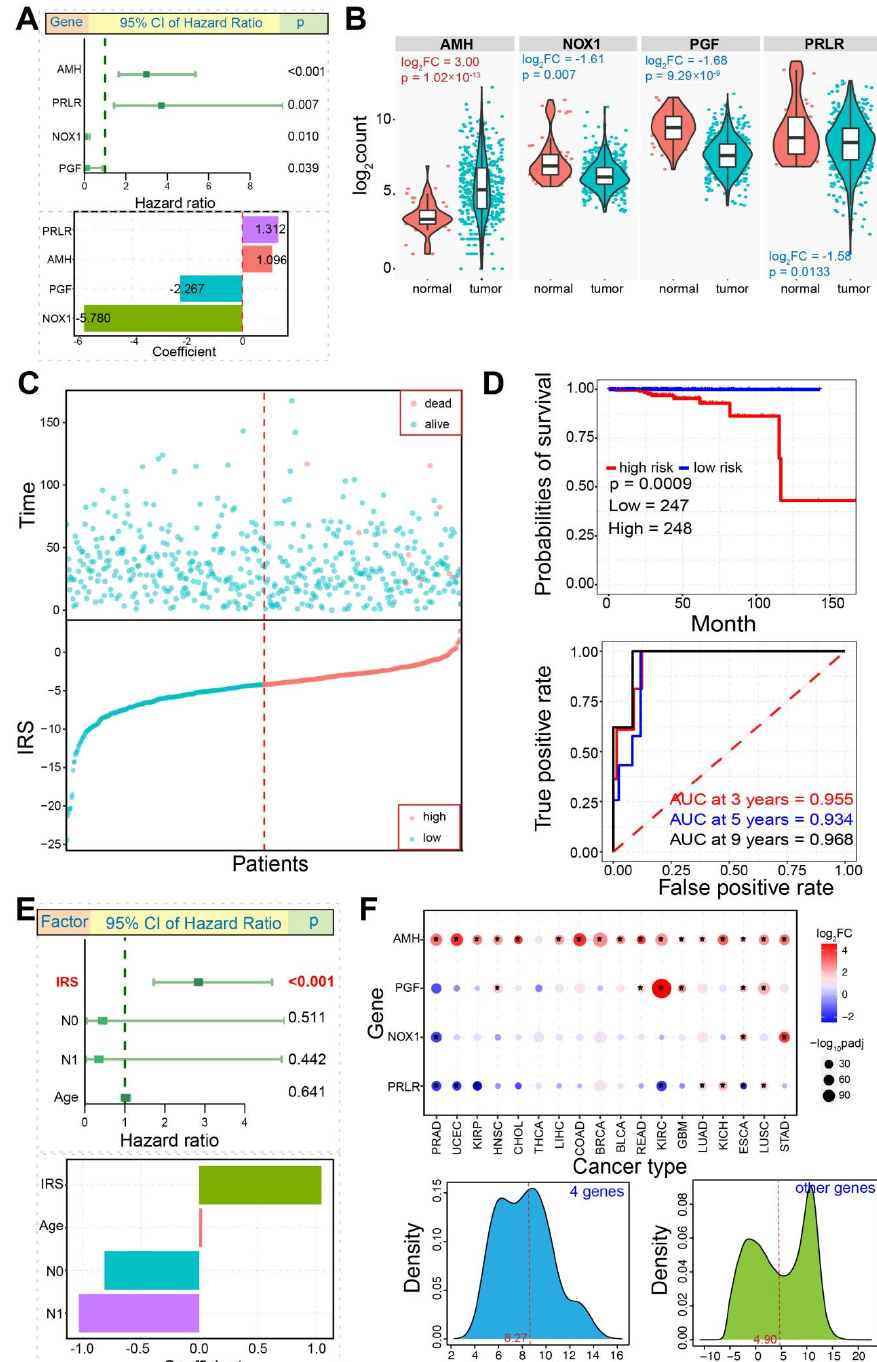
Figure 6. Four immune-related dysregulated genes are finally screened. ( A ). A graph presents distributions of hazard ratios, and corresponding coefficients for four selected genes are also pre- sented. ( B ). AMH is significantly up-regulated, while other genes are significantly down-regulated in tumor samples. The detailed log 2 FC and p values are also presented. ( C ). Distributions of risk scores and survival times in patients show that all dead patients are clustered together. ( D ). Distinct survival difference can be found between high risk and low risk groups, and the ROC curve shows better performance at each cutoff point. ( E ). A graph presents distributions of hazard ratios, and corresponding coefficients for IRS and other factors are also presented. ( F ). A pan-cancer expression analysis of four screened key genes shows dynamic expression across diverse tissues. The